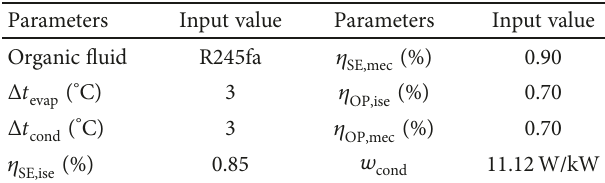
Table 2: Input values of parameters.